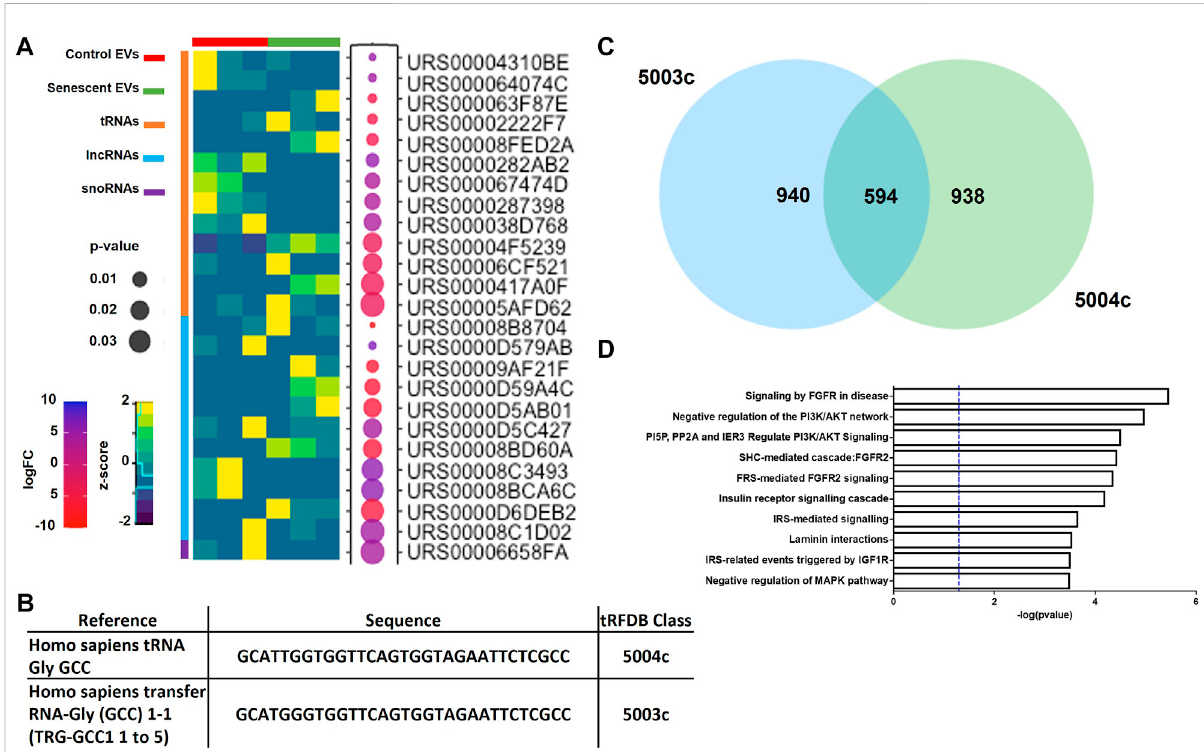
Differentially expressed small ncRNAs in EVs include tRNAs, lncRNAs and snoRNAs. (A) Heatmap of most signi fi cant differentially expressed small ncRNAs identi fi ed (See Table 2). (B) Sequences of two tRNAs of interest found in senescent EVs and were identi fi ed in tRF and tRFID databases of tRNAs which have miRNA functionality. (C) Overlap of predicted target genes identi fi ed for each tRNA using tRFTarget (See Supplementary Table S3 for predicted targets). (D) Functional annotation of predicted target genes using Reactome Pathway